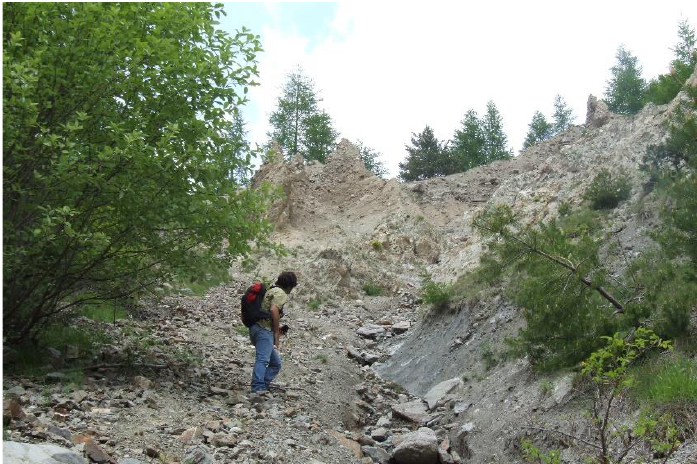
Figure 7. A detail of the head zone of a ravine out of those shown in Figure 6. The highly unstable conditions of the highly fractured bedrock can be noticed, as well as the debris mantle continuously filling up the stream incisions.